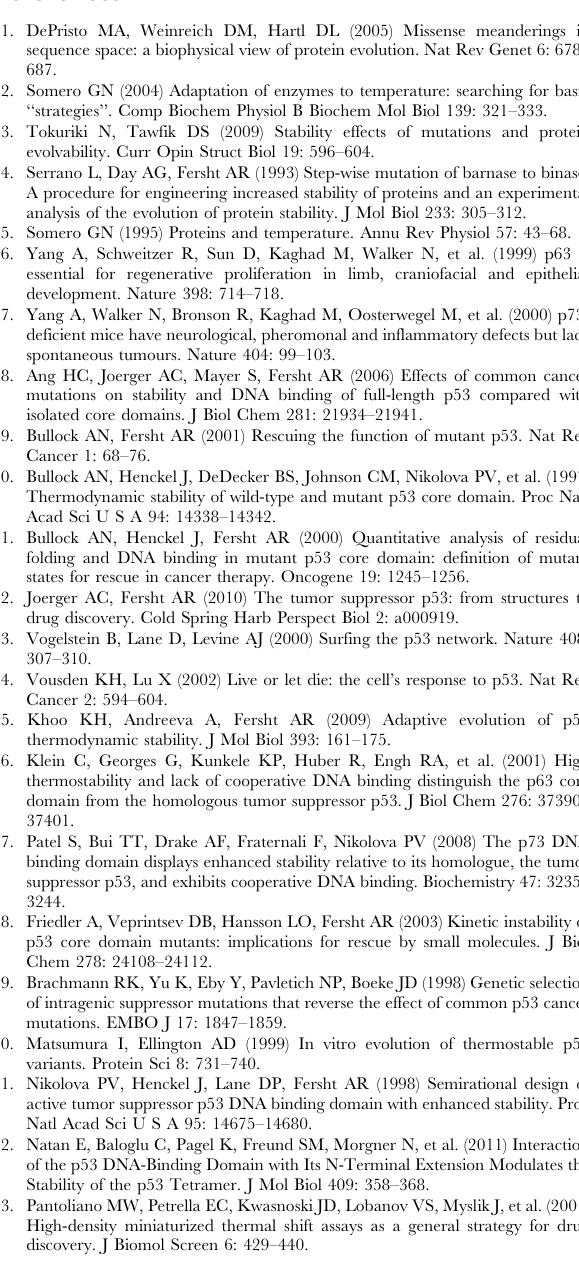
Figure S1 p53 family domain organisation.